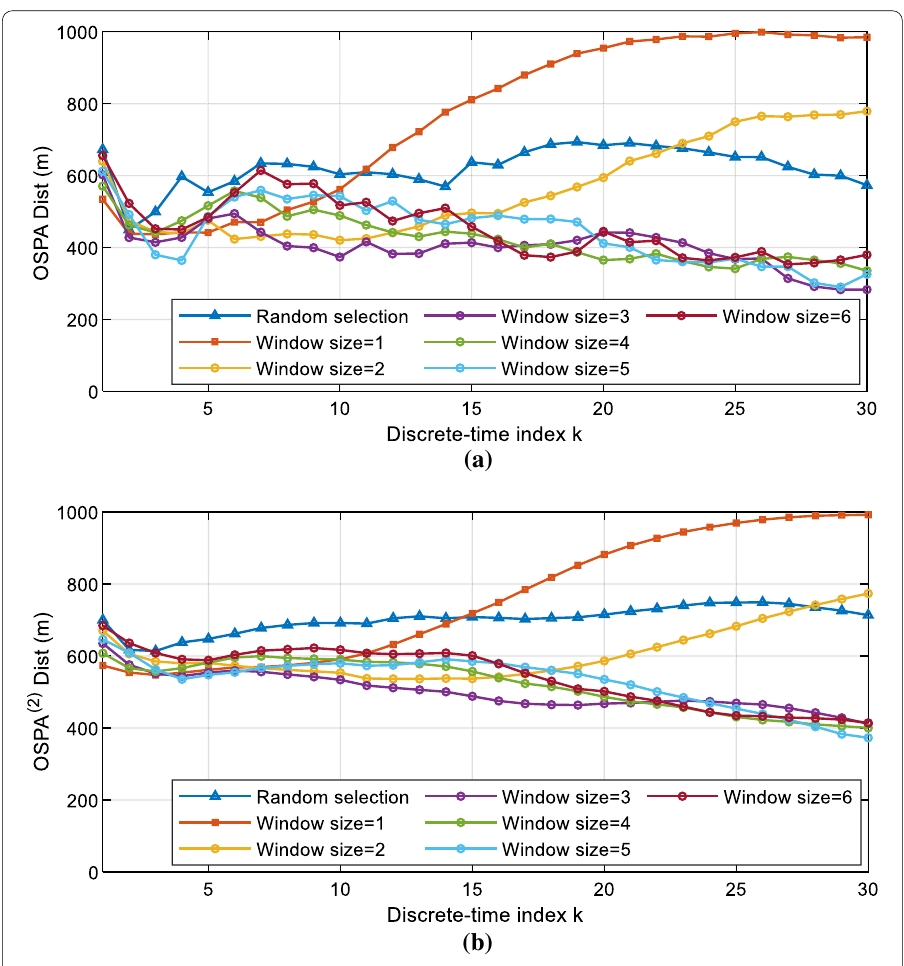
Fig. 5 Average OSPA and OSPA ( 2 ) errors in single target